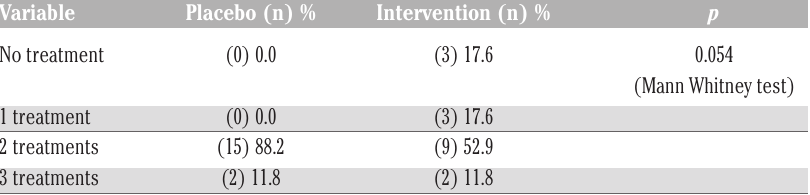
Table 1. Number of treatment cycles during induction therapy (phase I).